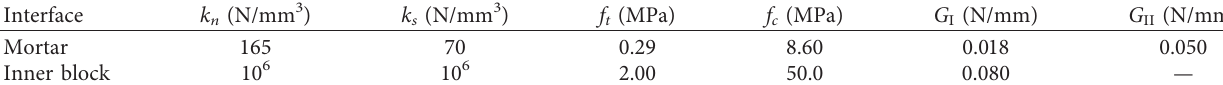
Figure 8: Deep beam test configuration. Table 2: Mechanical properties of mortar joints and inner block joints of the masonry deep beam test.